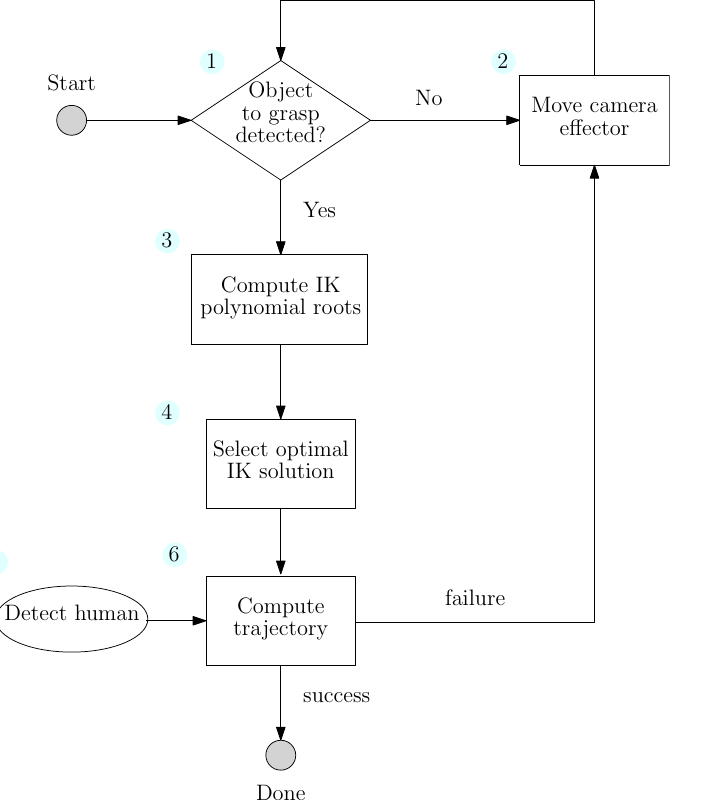
Figure 2. Flow chart of our occlusion-free pick-and-place solution for collaborative assembly